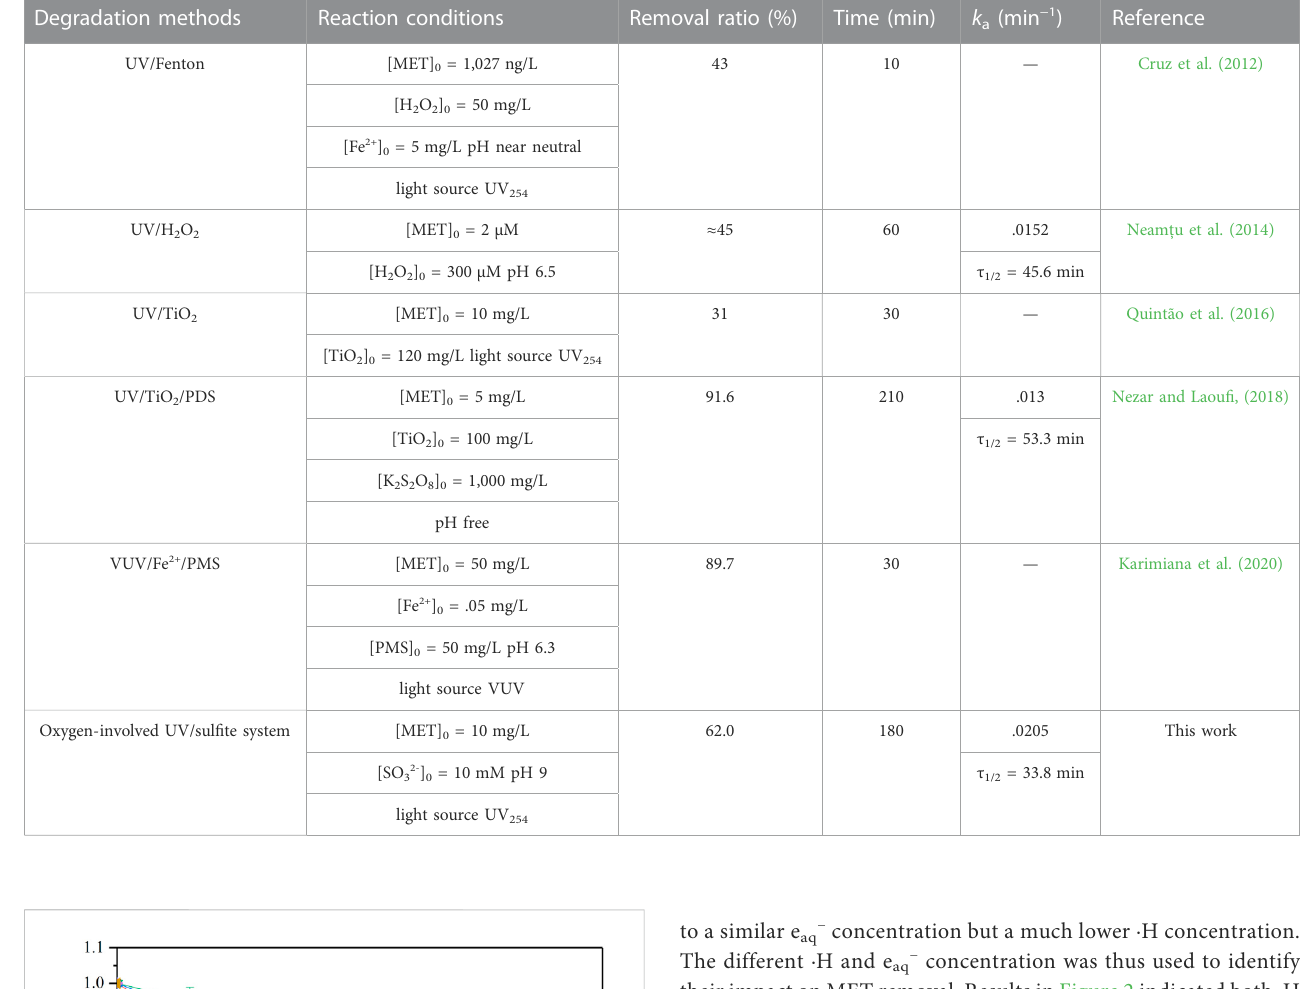
TABLE 1 Summary of previously reported literature for photolysis of MET.